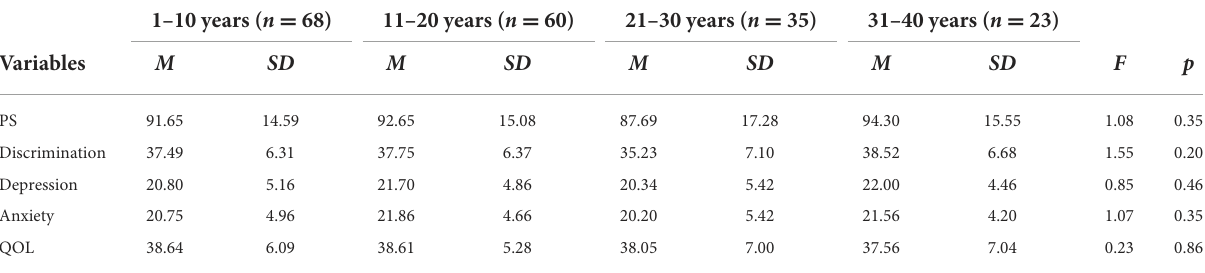
TABLE 5 ANOVA analysis showing mean, standard deviation and F value for duration of disease among epilepsy patients on variables of the